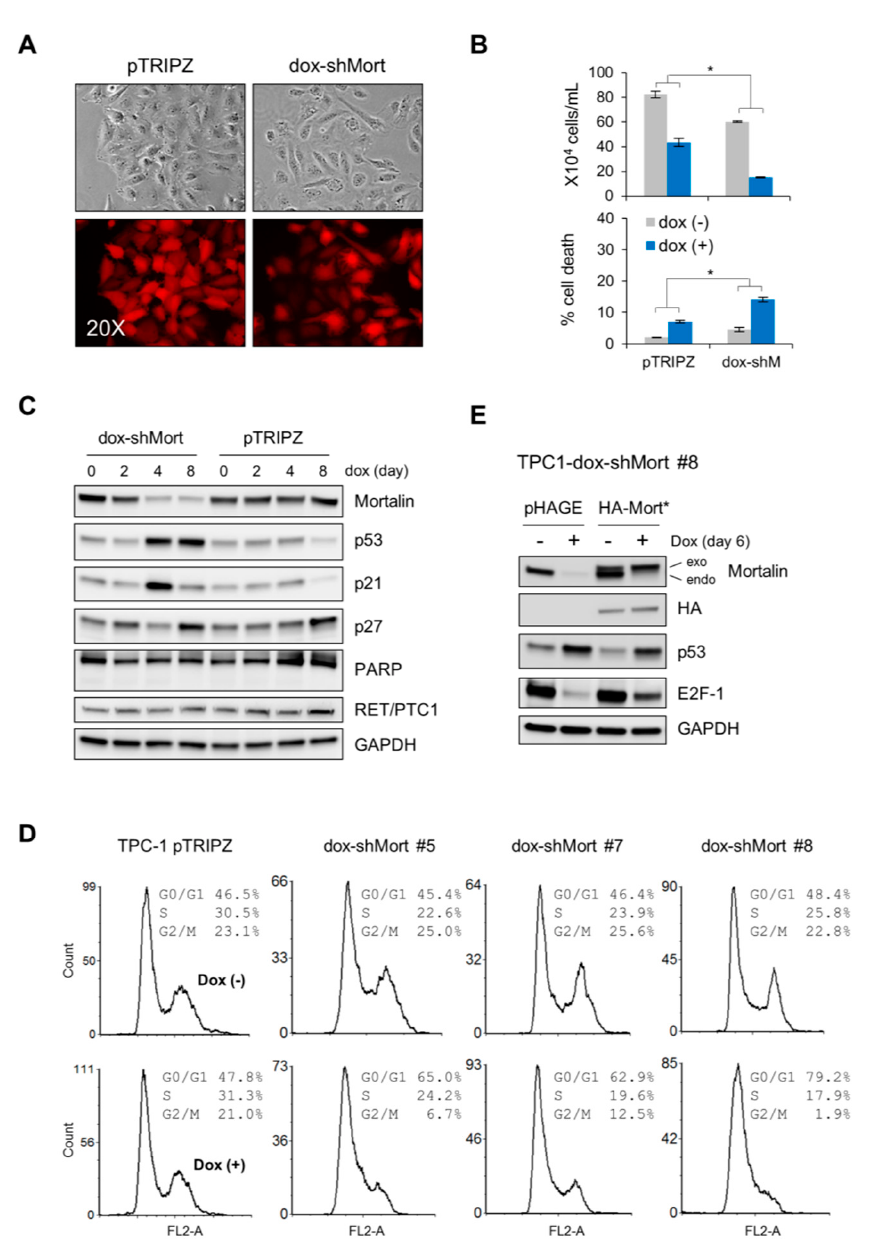
Figure 2. Mortalin knockdown induces growth inhibition in the PTC cell line, human PTC (TPC-1). ( A – C ) PTC-1 cells were infected with the pTRIPZ lentiviral vector harboring a doxycycline (dox)-inducible shRNA construct that targets mortalin mRNA (dox-shMort), or with the empty pTRIPZ virus. ( A ) Dox-induced red fluorescent protein (RFP) expression indicates infection efficacy. ( B ) Trypan blue exclusion analysis of live and dead cells at dox treatment day 8 (mean ± SD, n = 3), * p < 0.05. ( C ) Western blot analyses of total cell lysates harvested after dox treatment for indicate time. Glyceraldehyde-3-phosphate dehydrogenase (GAPDH) was used as the control for equal amounts of protein loading. ( D ) Cell cycle analysis of different clones of TPC-1 stably infected with pTRIPZ-dox-shMort (#5, #7, and #8) after 8 day dox treatment. ( E ) Cells of TPC-1 dox-shMort clone #8 were infected with lentiviral pHAGE expressing non-shMort-targetable mortalin mRNA (Mort*). Western blotting of total cell lysates indicates that HA-Mort* can abrogate mortalin knockdown effects on p53 and E2F1. Empty pHAGE was used as the control.